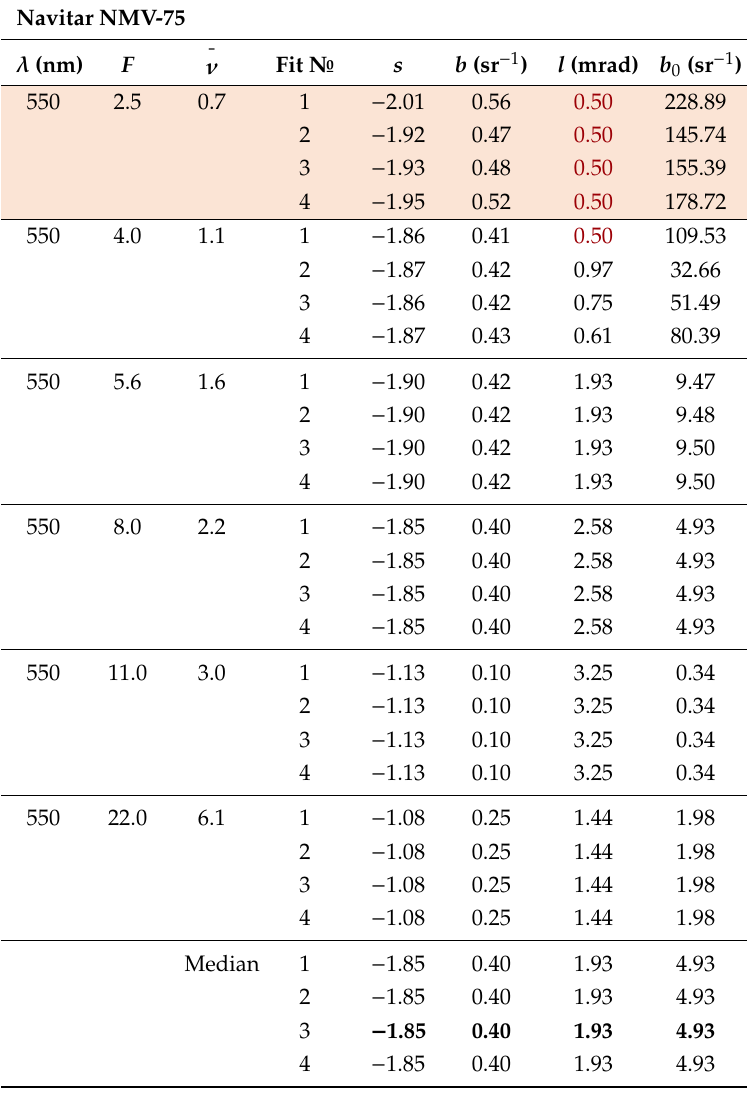
Table A5. Fit results for the lens Navitar